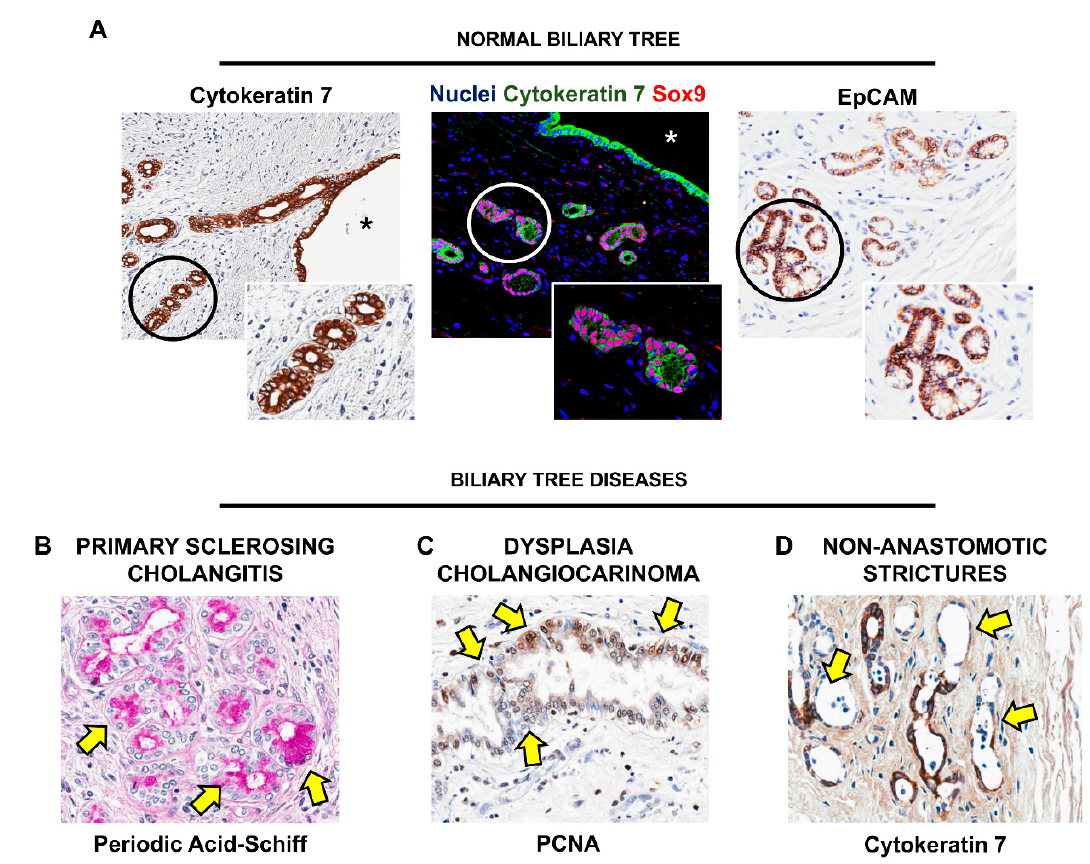
Figure 3. Biliary Tree Stem/progenitor Cells (BTSCs) and peribiliary glands (PBGs) in human biliary tree. PBGs are located in normal large intrahepatic and extrahepatic bile ducts ( A ) and are in direct communication with the bile duct lumen (asterisks). In PBGs, BTSCs can be identified by the positivity to stem cell markers, such as Sox9 and EpCAM. Circled areas are magnified in the boxes. In diseased ducts, such as Primary Sclerosing Cholangitis ( B ), dysplastic/neoplastic transformation ( C ), and non-anastomotic strictures ( D ), PBGs showed different degrees of mucinous metaplasia (arrows in B ), proliferation (Proliferating Cell Nuclear Antigen: PCNA, arrows in C ) and necrosis (arrows in D ). Original Magnification: 10× ( A ) and 20× ( B – D ).